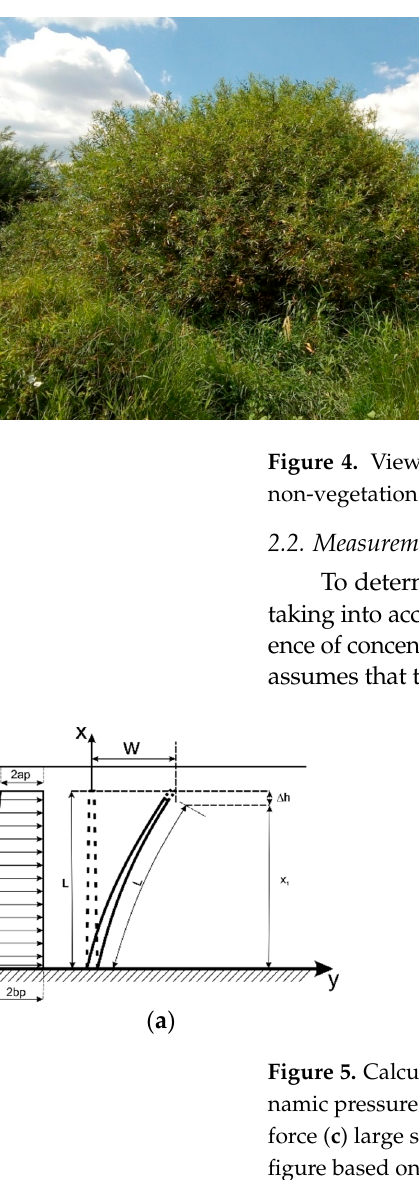
Figure 3. View of shrub 2 during the vegetation conditions (( left photo )—14 July 2020) and the non-vegetation conditions (( right photo )—13 December 2020).